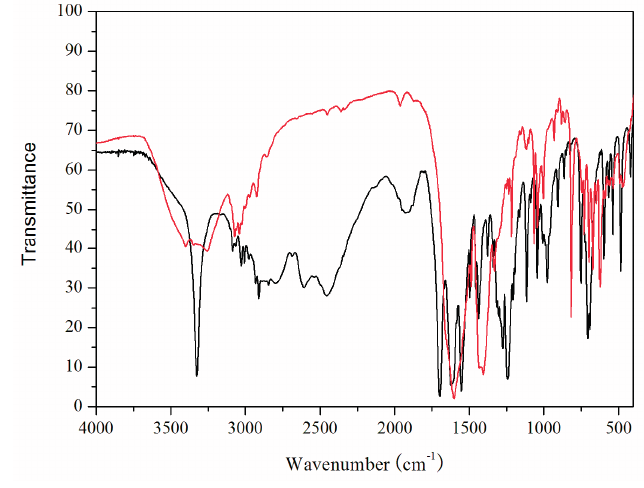
Figure 5. The IR spectra of N -acetyl- L -phenylalanine (black) and complex 1 (red).